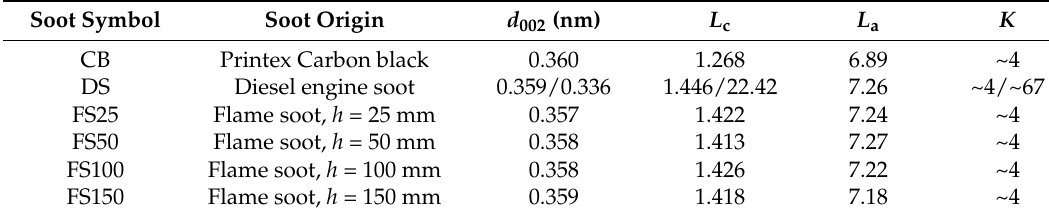
Table 2. Crystalline dimensions for various soot samples.